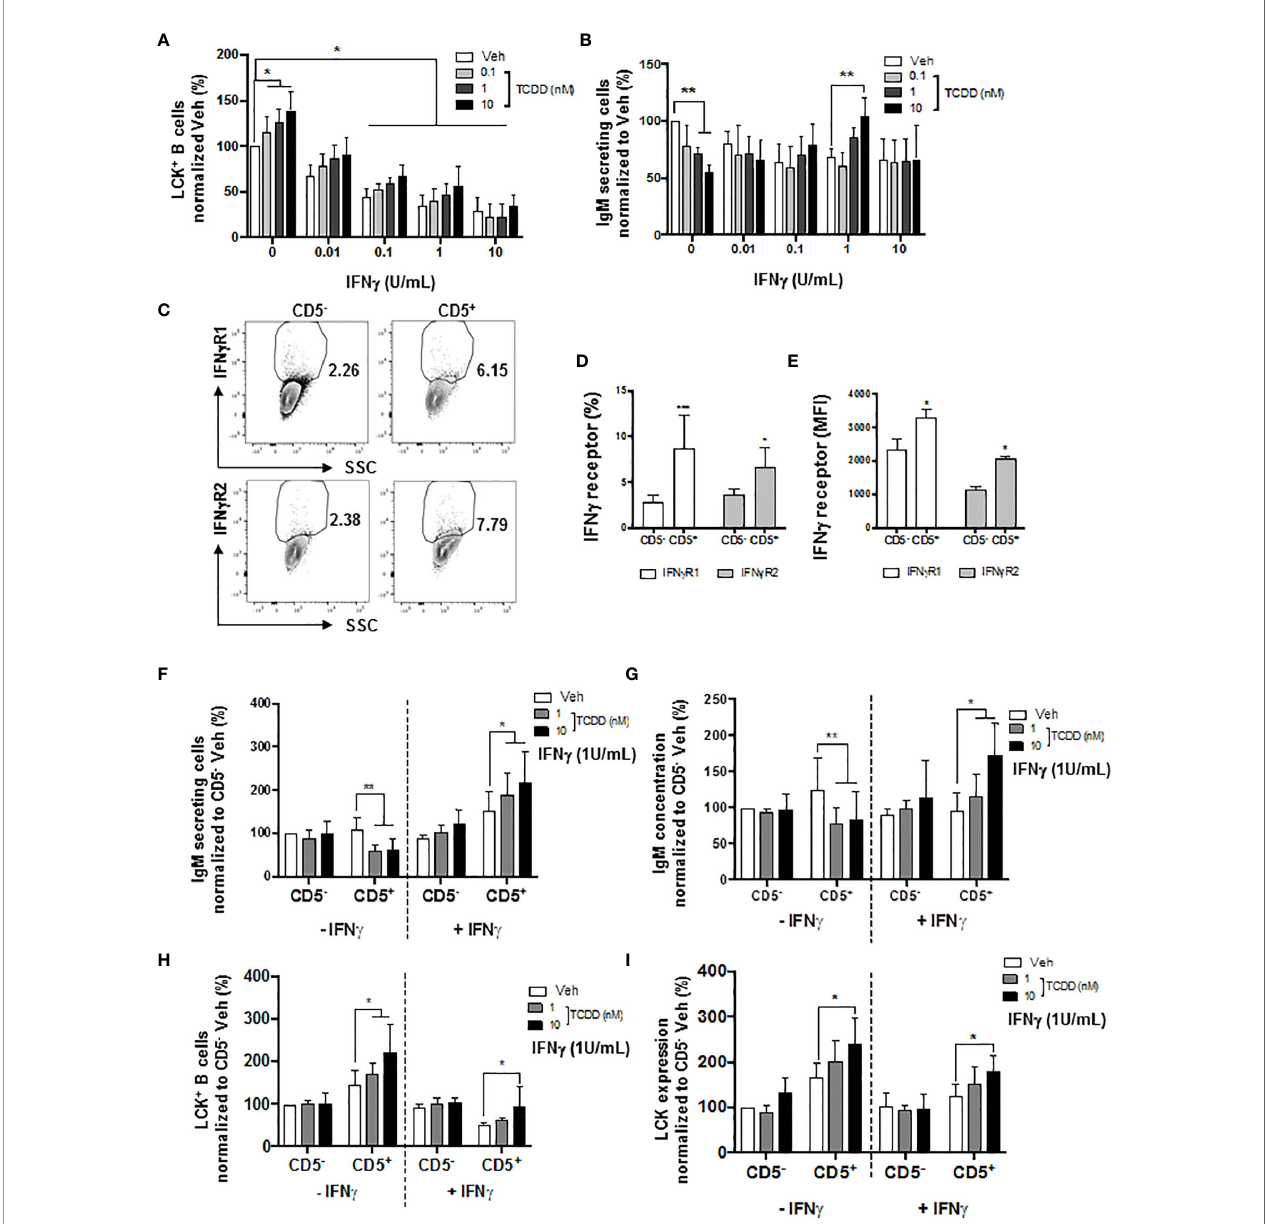
FIGURE 10 | IFN g treatment reversed the AHR-mediated suppression of the IgM response through a decrease of LCK in CD5 + ILBs. Human CD5 +/- B cells were activated/treated with soluble PDL1 or PDL2 on day 0 and cultured for 7 days as described previously. In addition, IFN g treatment (1 U/mL) was provided on day 0. (A) Averaged frequency of LCK + total B cells; (B) Averaged number of IgM secreting cells in CD19 + B cells; (C) Representative fl ow cytometry plots of IFN g R1 + and IFN g R2 + cells; (D) Averaged frequency of IFN g R1 + and IFN g R2 + cells; (E) Averaged MFI of IFN g R1 and IFN g R2 within CD5 +/- populations; (F) Averaged number of IgM secreting cells; and (G) Averaged IgM concentration within CD5 +/- culture supernatants treated with IFN g ; (H) Averaged percentage of LCK + cells and; (I) averaged LCK MFI within CD5 +/- populations treated with IFN g . Determinations were made using B cells from 6 human donors (N = 6) from two independent experiments. For (A, B) , data presented in the fi gure were normalized to the Veh group without IFN g treatment. For F-I, data presented were normalized to the CD5 - Veh without IFN g treatment. Signi fi cant differences are indicated by * p < 0.05, ** p < 0.01 and *** p < 0.001 (two-way ANOVA following with Fisher ’ s LSD post hoc